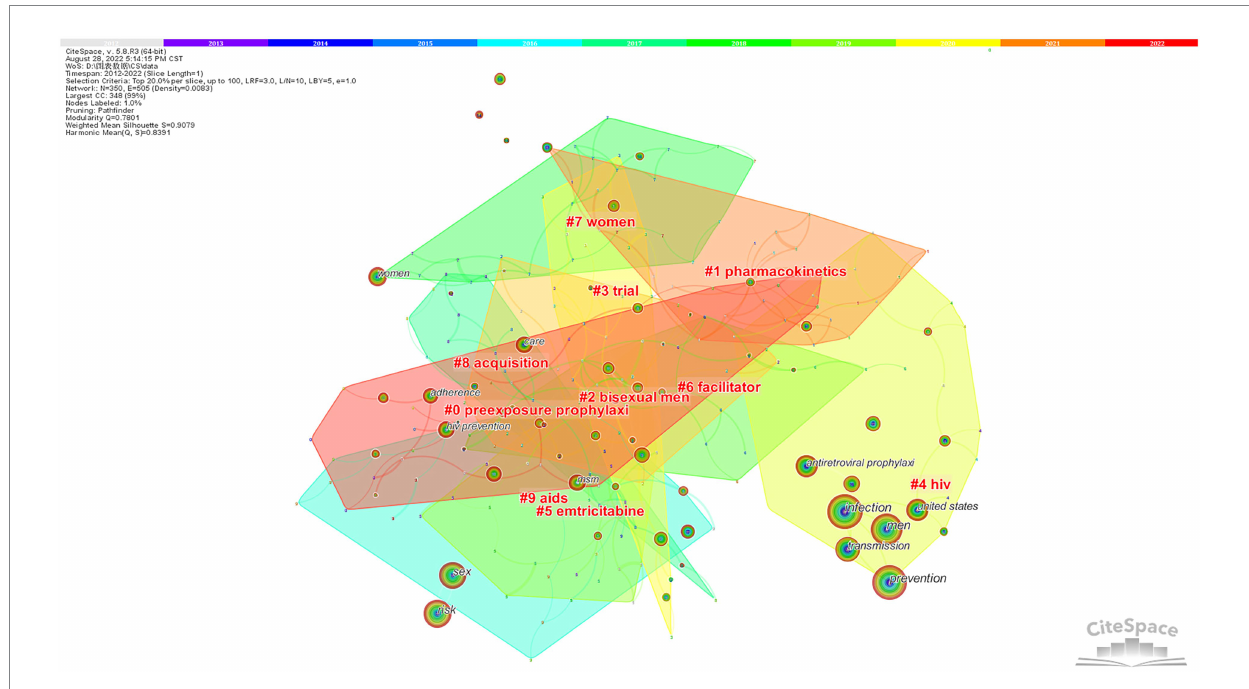
FIGURE 8 Keyword cluster analysis co-occurrence map.